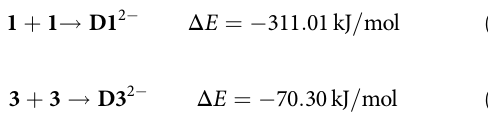
a Obtained from the potential at peak of oxidation and reduction. b Calculated from HOMO = LUMO- Δ E d . c Calculated using the empirical LUMO = − (4.44+ E red onset ). d Estimated from the onset of normalized absorption spectra. Cyclic voltammetry measured using a glassy carbon electrode as a working electrode, a platinum rod as a counter electrode, and Ag/AgNO 3 as a reference electrode